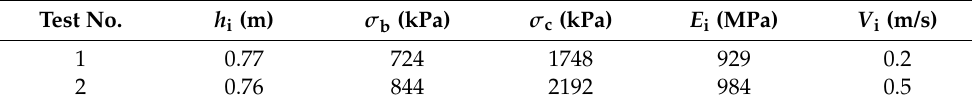
Table 3. Test matrix with the model speed and ice properties.